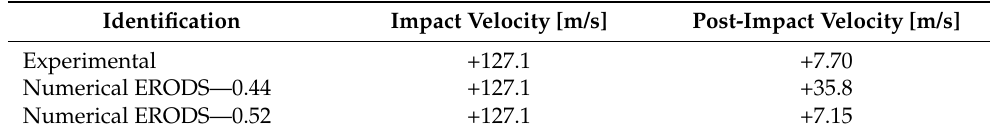
Table 15. Validation impacts test